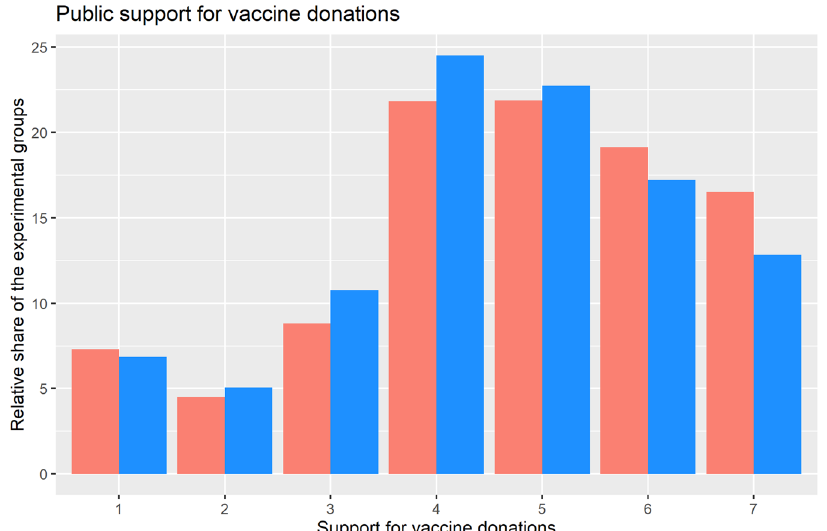
Fig. 1 Support for vaccine sharing, separated by experimental groups ( ‘ information treatment ’ ); treatment group in red, control group in blue; likert scale ranging from complete objection to full support. Data collected in Germany in May 2021, n = 4022 (treatment group n = 1974, control group n =